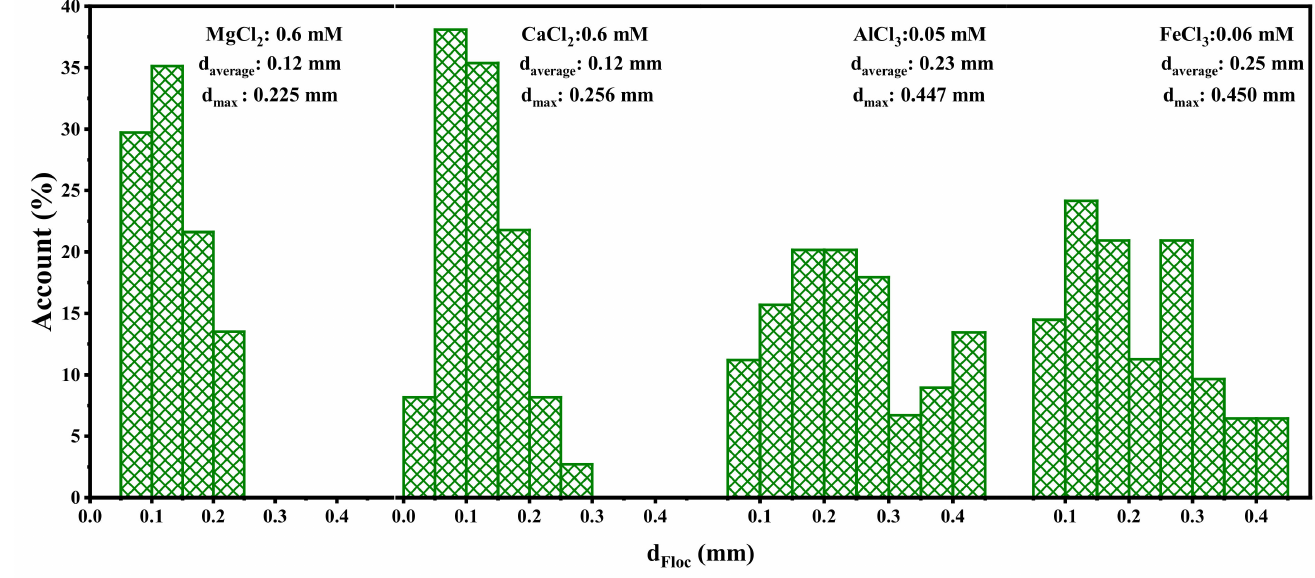
Figure 6. Floc size distribution for different coagulants under nearing